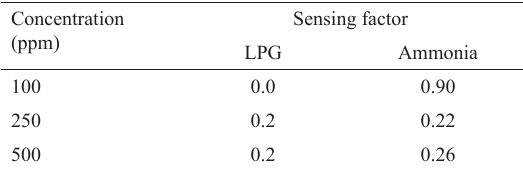
Table 2. Response factor values for sensing LPG and ammonia gas by